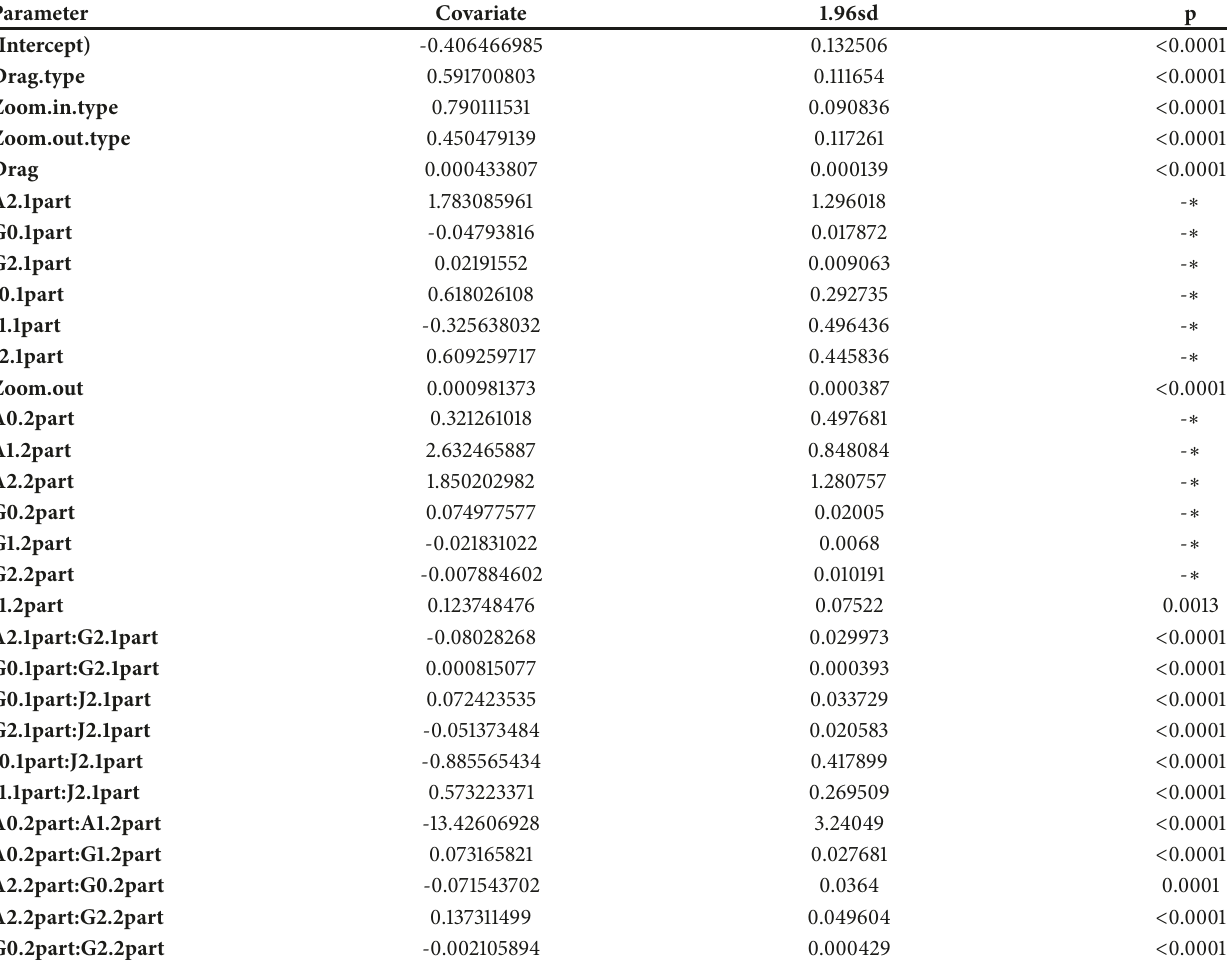
Table 3: Coefficients for fixed effects in the mixed effects linear regression of log (completion time) on task type and sensor RMS, where participants were included as a random effect. p-values for main effects include removal of any interaction terms. Estimate for participants is the random effect parameter. ∗ indicates that fields marked with an asterisk are for covariates that interact with other variables. Pa r a